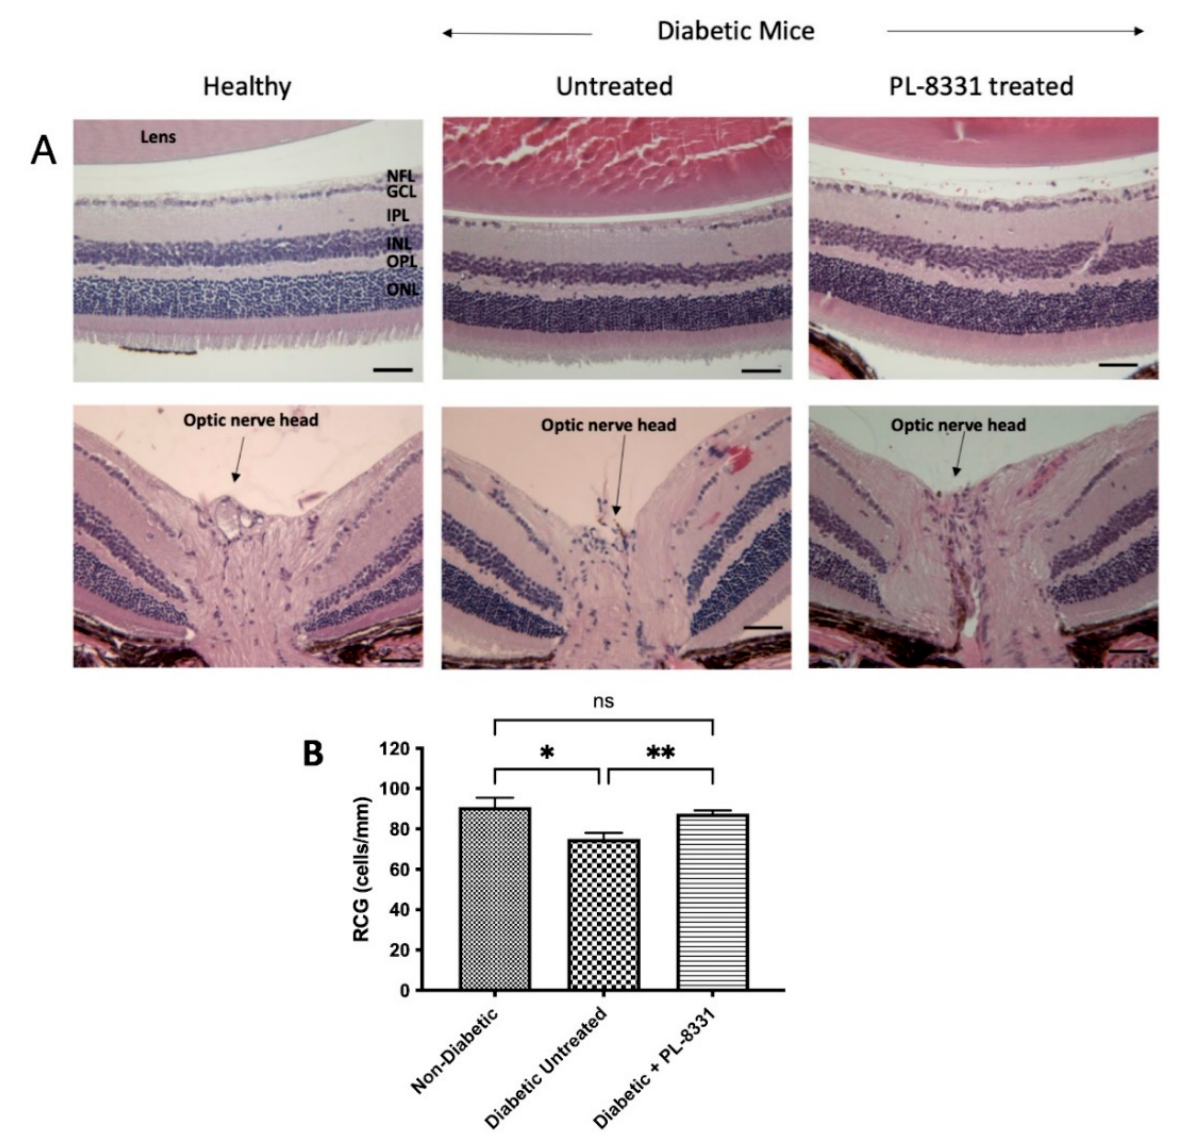
Figure 3. The effects of PL-8331 treatment on retinal cell survival in diabetic mice. The eyes of PL- 8331-treated or untreated mice with diabetes for 16 weeks were collected, sectioned, hematoxylin and eosin stained, and retinal sections were examined. ( A ) The upper panels are cross-sections of